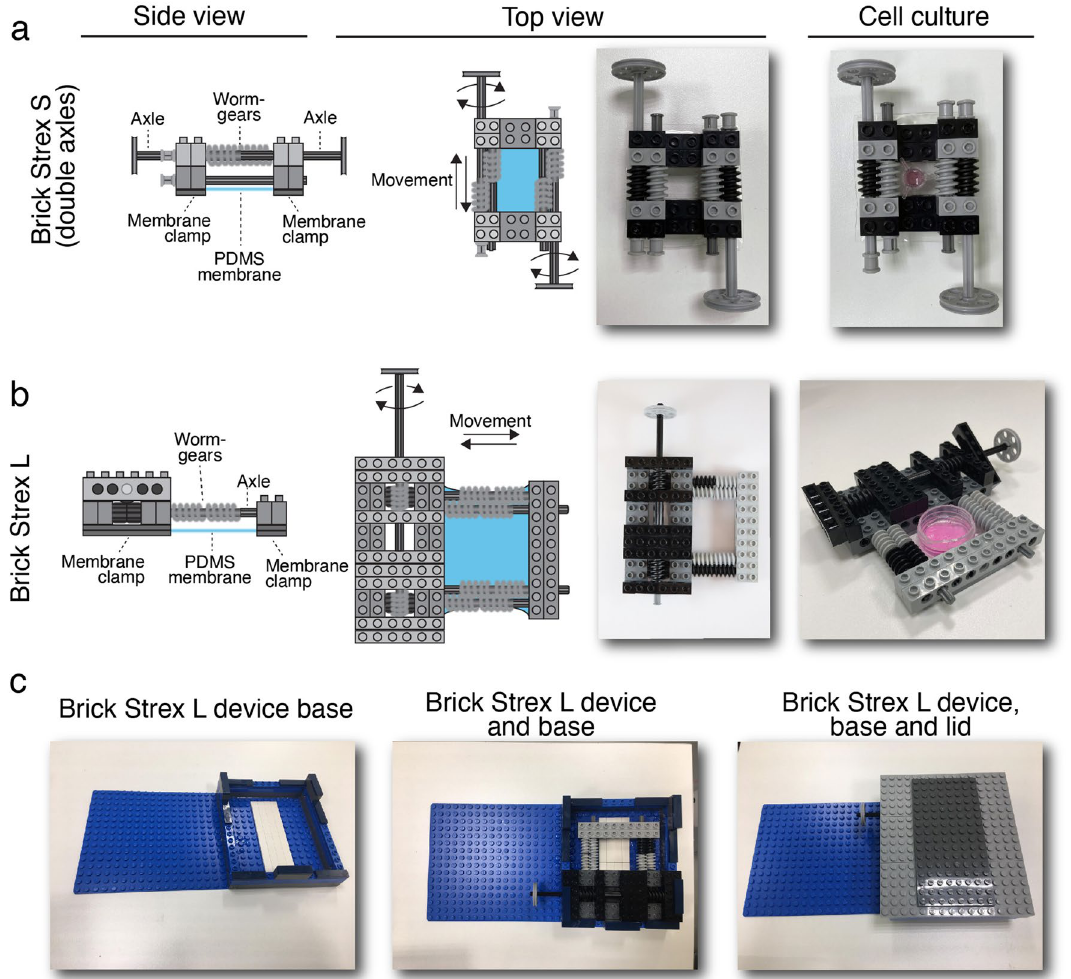
Figure 1. Brick Strex devices and their structure. Design of the two Brick Strex cell stretching devices built of LEGO bricks. ( a ) Side and top views of Brick Strex S device (left and middle panels). ( b ) Side and top views of Brick Strex L device. Both devices can be easily combined to cell culture with or without a cell culture well attached to the membrane (a and b, right panels). ( c ) Brick Strex L device base alone (lower left panel), combined with the device (lower middle panel) and with the lid attached (lower right